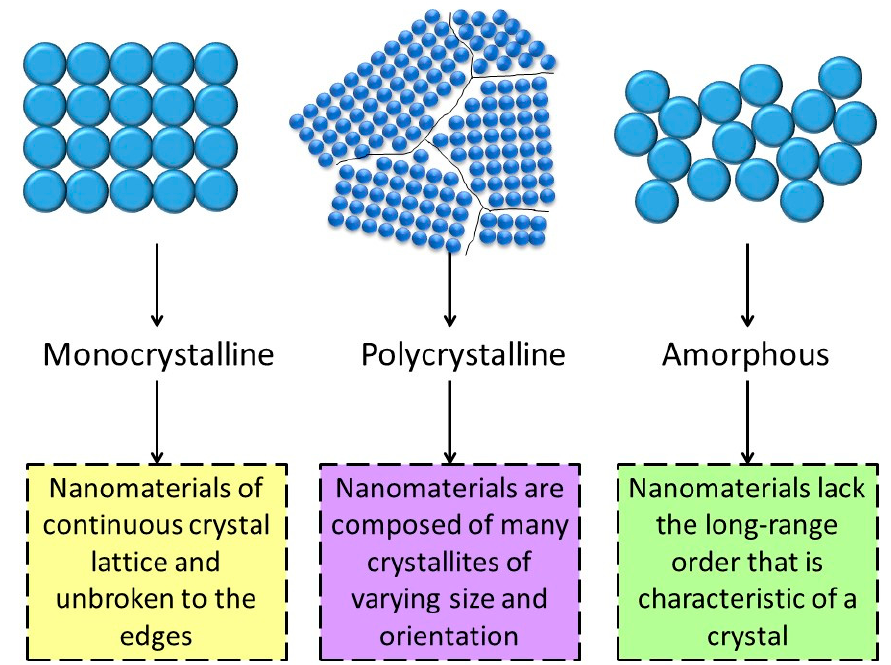
Figure 11. Nanomaterials Classifications based on their crystallinity.